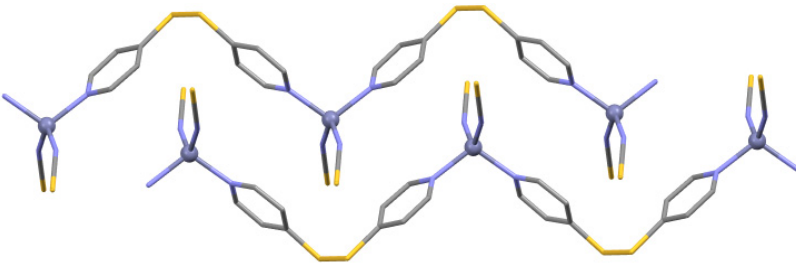
Figure 14. Compact arrangement of two adjacent arched chains in [Zn(NCS) (CEBLUR01), containing μ - dtdp ligands of opposite